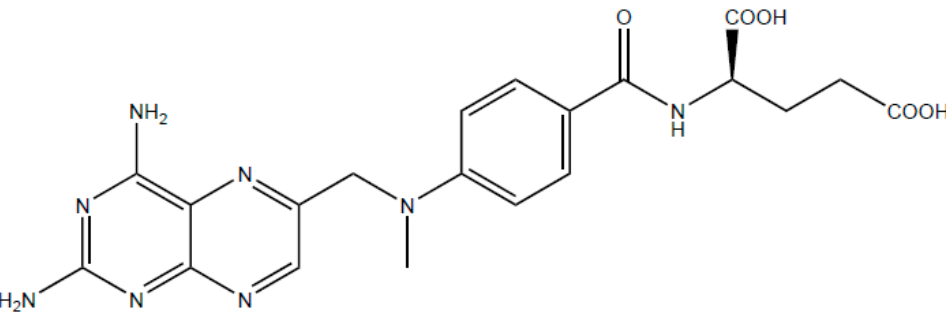
Figure 1. Chemical structure of methotrexate.